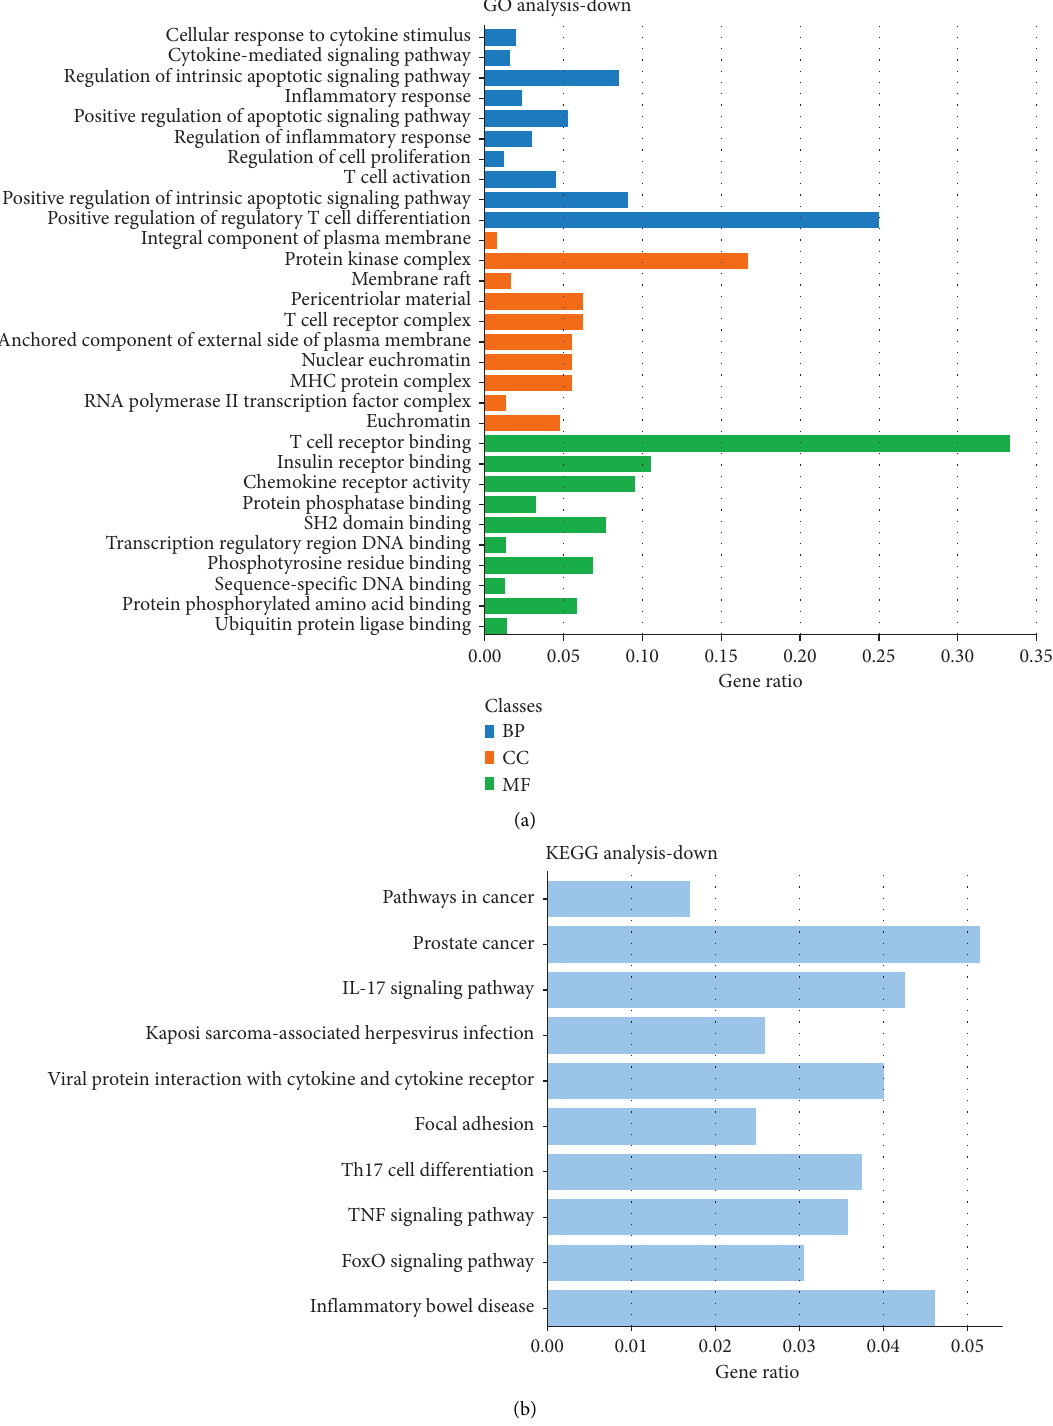
Figure 3: Downregulated DEGs’ analysis. (a) GO analysis. Blue represents BP, orange represents CC, and green represents MF. (b) KEGG pathway enrichment